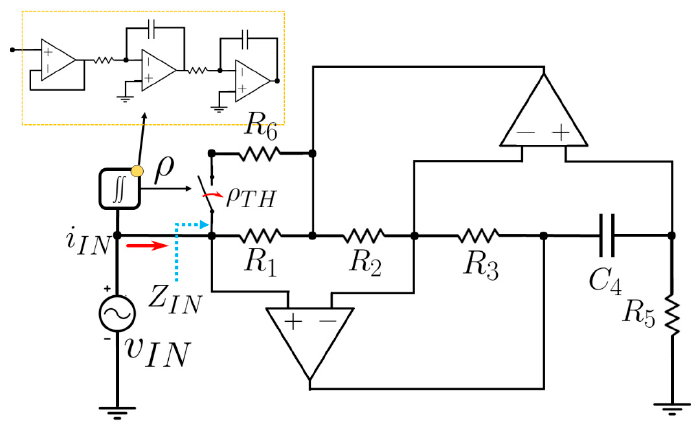
Figure 3. Schematic circuit of the two-state meminductor emulator.